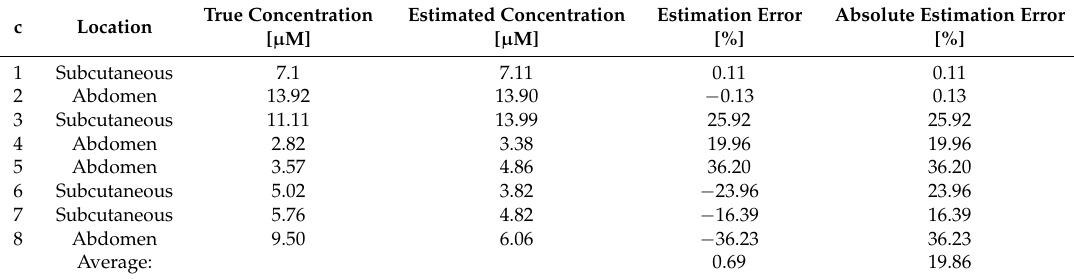
Table 1. Animal concentration ratio estimation results